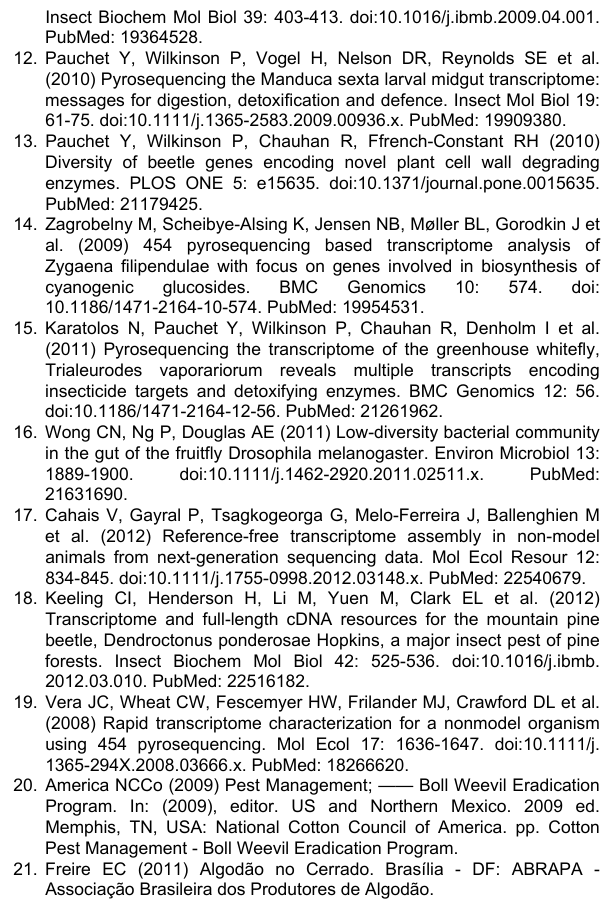
Figure S3. Gene ontology (GO) categories for A. grandis transcriptome. The terms were classified on level 2, 3 and 5 in the (A) Biological Process , (B) Cellular Component and (C) Molecular Function , respectively. The dominant terms for Molecular function are transporter activity and binding, while the dominant term for Biological process is pigmentation. Within Cellular component the dominant terms are evenly divided between organelle, cell part and organelle part. The percentage of contigs in each GO term is shown.